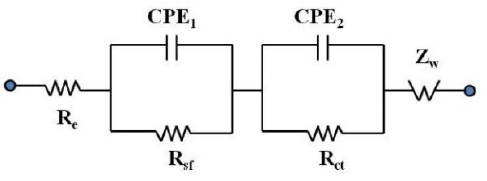
Figure 10. Electrochemical electric circuit (EEC) used to fit the EIS data. Table 2. Impedance parameters obtained after fitting the EIS experimental data based on the EEC model shown in Figure 9.